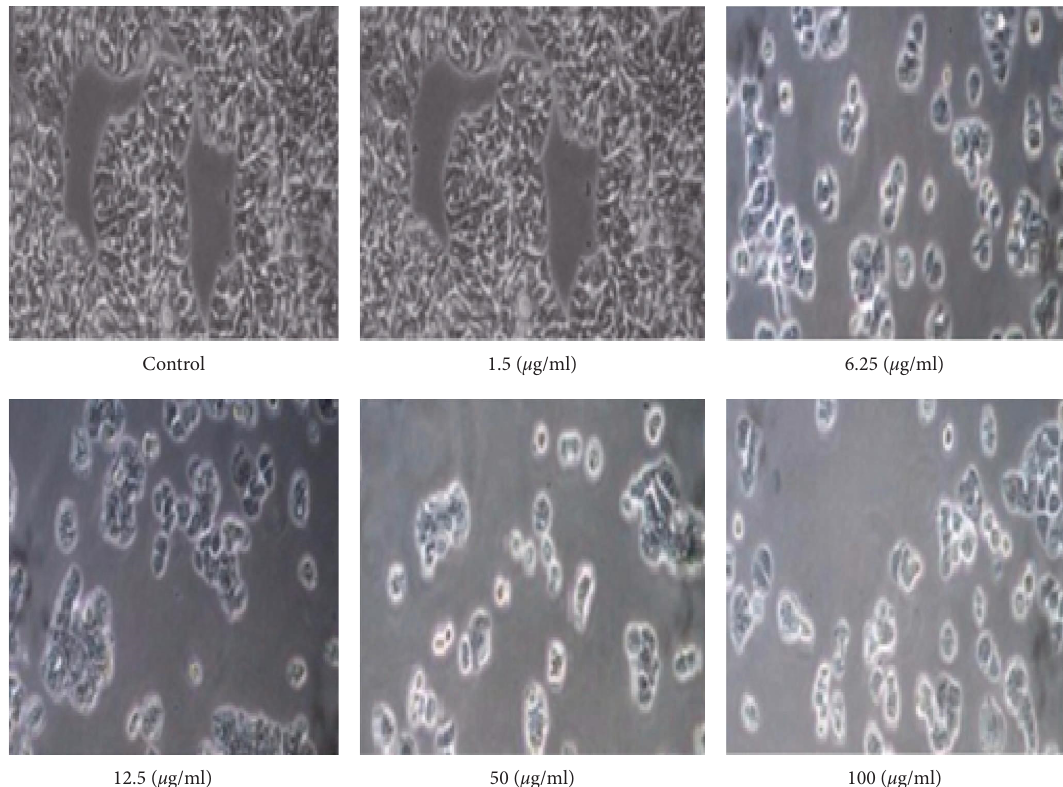
Figure 11: Morphological alterations in MCF-7 lines caused by diferent dosages of SeWt-AgNPs.